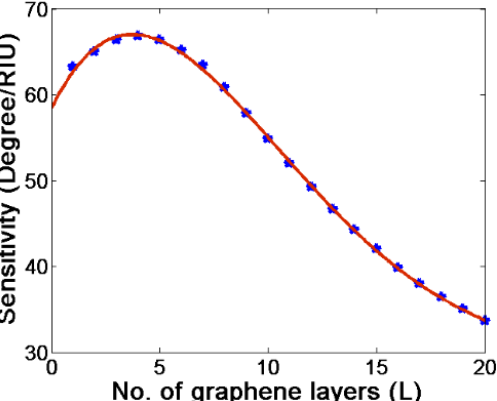
Figure 8. Sensitivity variation with no. of graphene layers for bio sensing probe with 50 nm of Au and representative 11 nm of silicon. Maximum sensitivity is calculated to be 66.80 degree/RIU. The star symbols are simulated data points, which are fitted with red line.